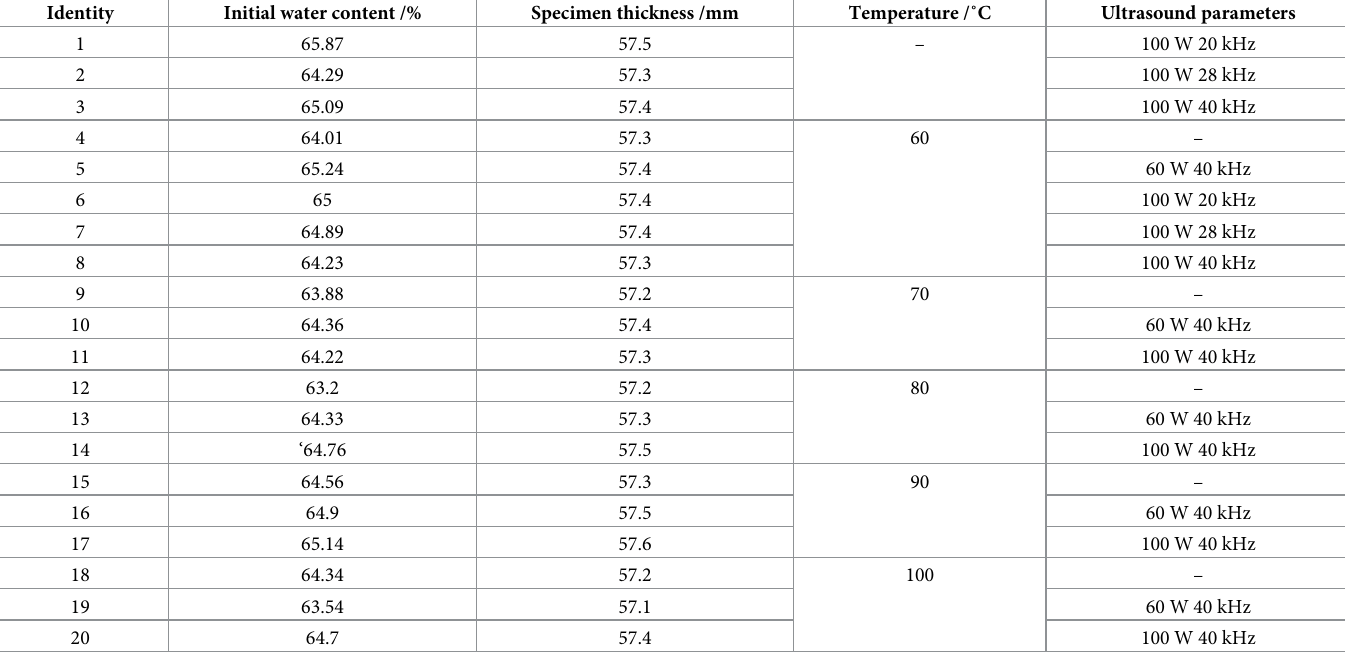
Table 1. Initial data for each